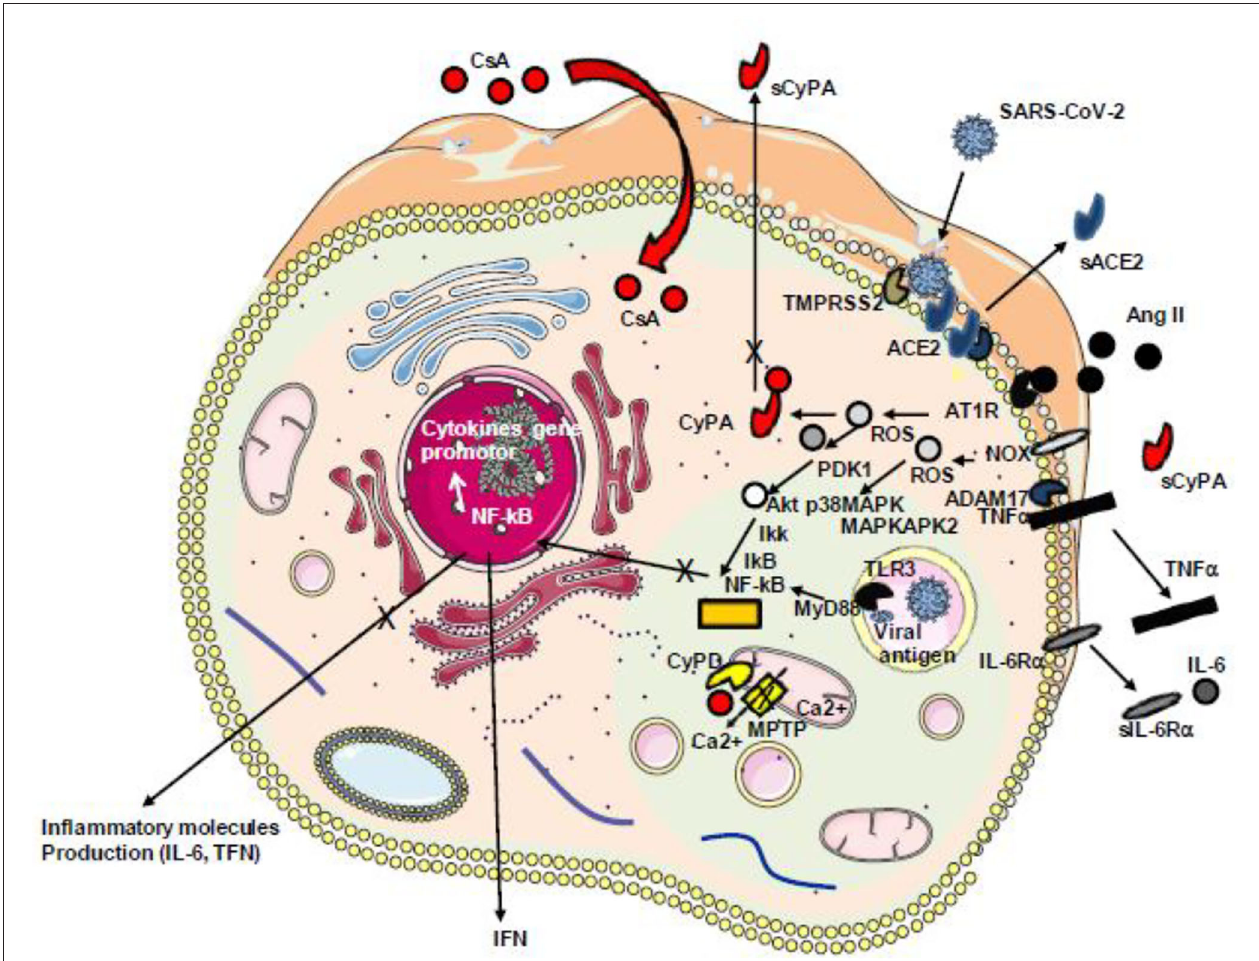
FIGURE 7 | Schematic representation of Ang II/AT1R-induced inflammatory pathway with cytokine release. During infection with SARS-CoV-2, the virus binds ACE2 reducing the ACE2 transcription and inhibiting the capacity of ACE2 to mediate the cleavage of angiotensin II (Ang II) into angiotensin 1–7. The accumulation of Ang II triggers signals through its receptor AT1R inducing ROS production. ROS triggers the secretion of CyPA that acts as a stress factor activating the ERK1/2 kinase and overproduction of ROS through a positive feedback loop. ROS-sensitive 3-phosphoinositide-dependent protein kinase (PDK1) activation that contributes to phosphorylation and activation of Akt. A parallel pathway involves the NOX-dependent generation of ROS that activates the p38 MAP kinase (p38MAPK) which recruits MAPKAPK2 leading to AkT phosphorylation on a second amino acid position leading to full activation of the p38 MAPK–Akt complex, the activation of IKK αβ inducing the release of IkB from the I κ B–NF- κ B complexes, nuclear translocation of NF- κ B, and the production of cytokines including TNF- α and soluble IL-6 receptor (sIL-6R) via disintegrin and metalloprotease 17 (ADAM17) followed by the activation of the IL-6 amplifier (IL-6 AMP) which, by feedback regulation, activates both the NF- κ B and STAT3 transcription factors and the production of IL-6. SARS-CoV-2 itself activates NF- κ B via the TLR3 receptor. Ang II, angiotensin II; AT1R, angiotensin II type 1 receptor; ROS, reactive oxygen species; NOX, NADPH oxidase; IKK, IkB kinase; CyPA, cyclophilin A; TLR3, Toll-like receptor 3; NF- κ B, nuclear factor κ